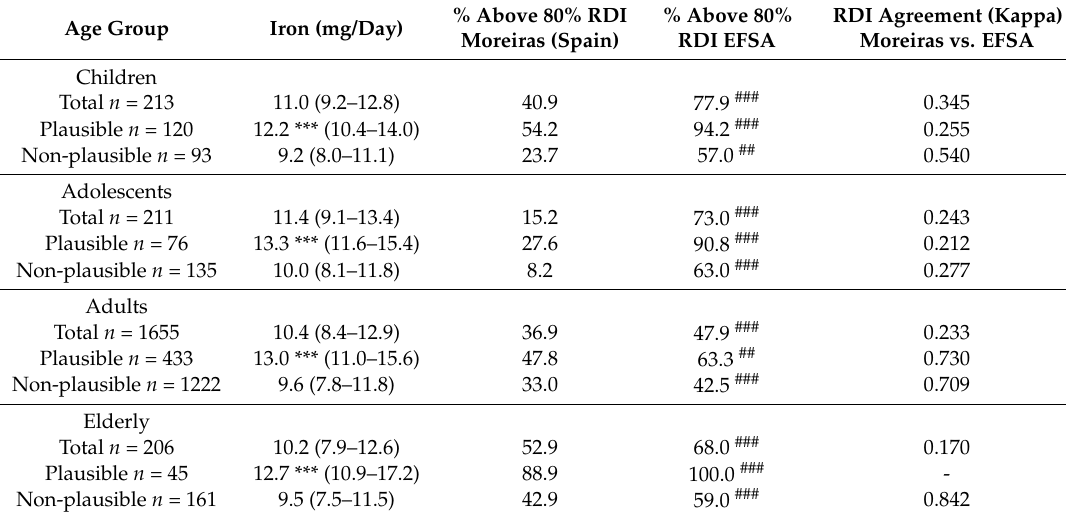
Table 5. Iron intake (mg/day) and prevalence of adequate (% population above 80% RDI) in ANIBES sample by age group and reporting and agreement (k) between Spanish [12] and EFSA [25] references.